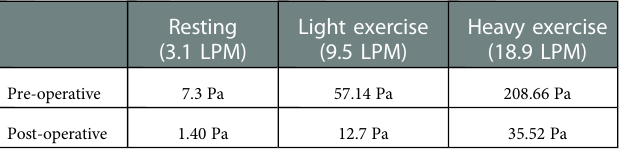
TABLE 1 Pressure drop (Pa) across the nasopharynx section for pre- and post-operative models under three inhalation conditions: resting